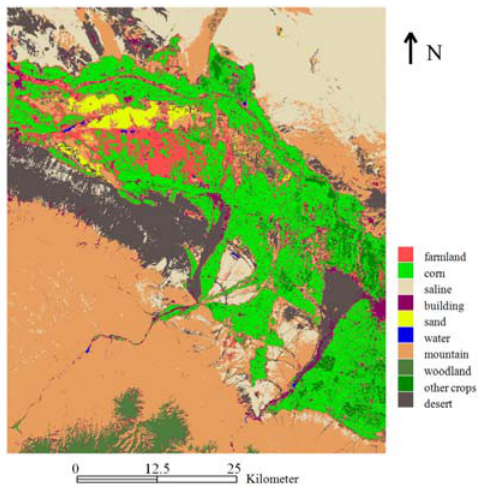
Figure. 4 The Classification map of study